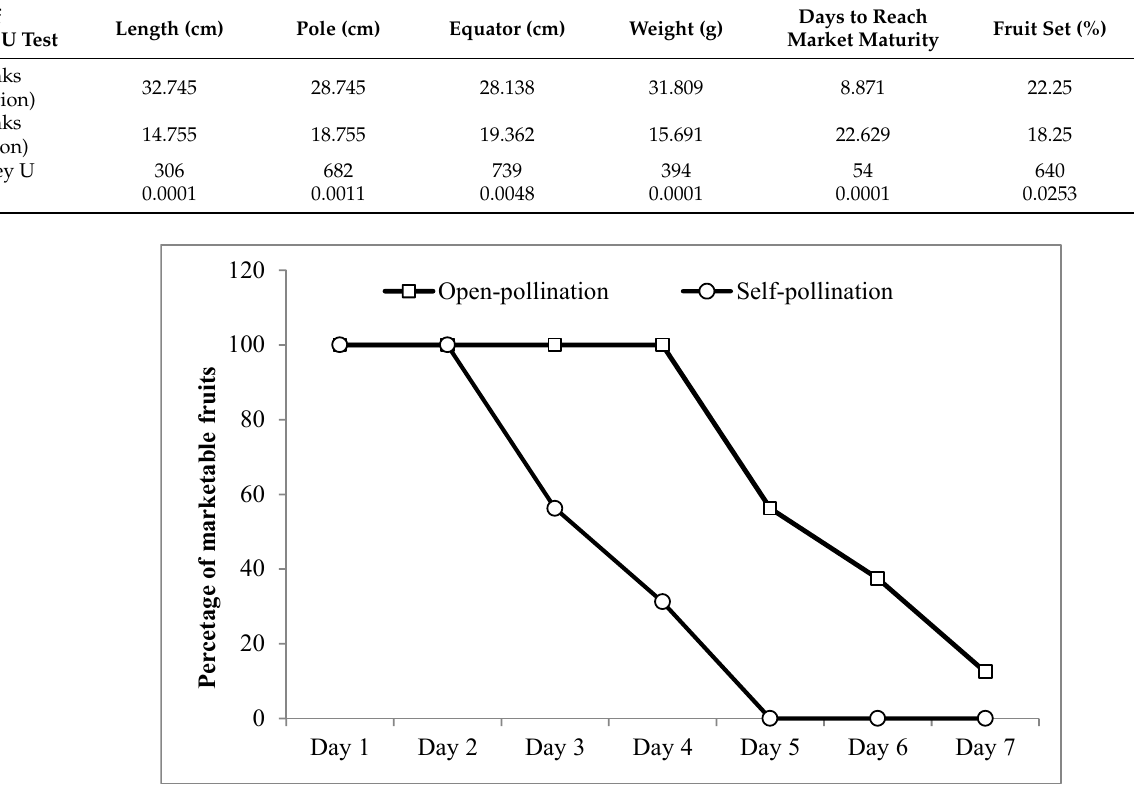
Table 3. Fruit length, pole, equator, weight, and fruit set resulting from single visits by the two honey bee species and two syrphid fly species.